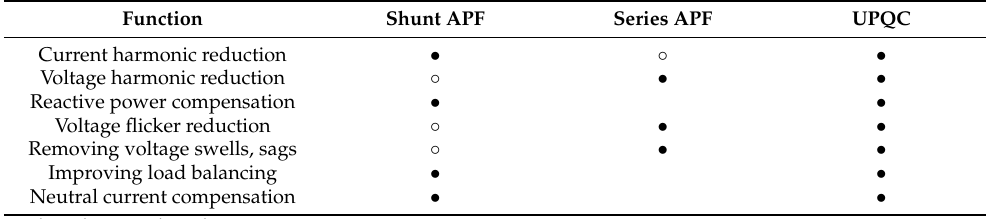
Table 1. Active power filter